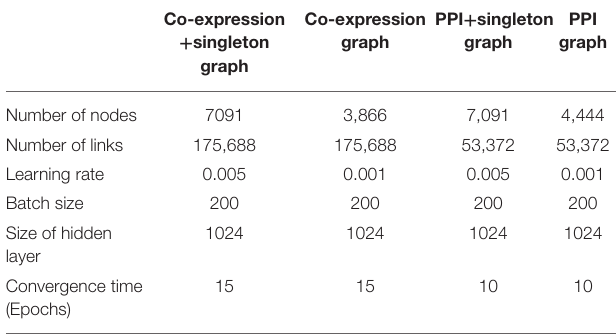
TABLE 1 | Property of four graphs established and the hyperparameters for four GCNN models trained by combined tumor and normal samples.